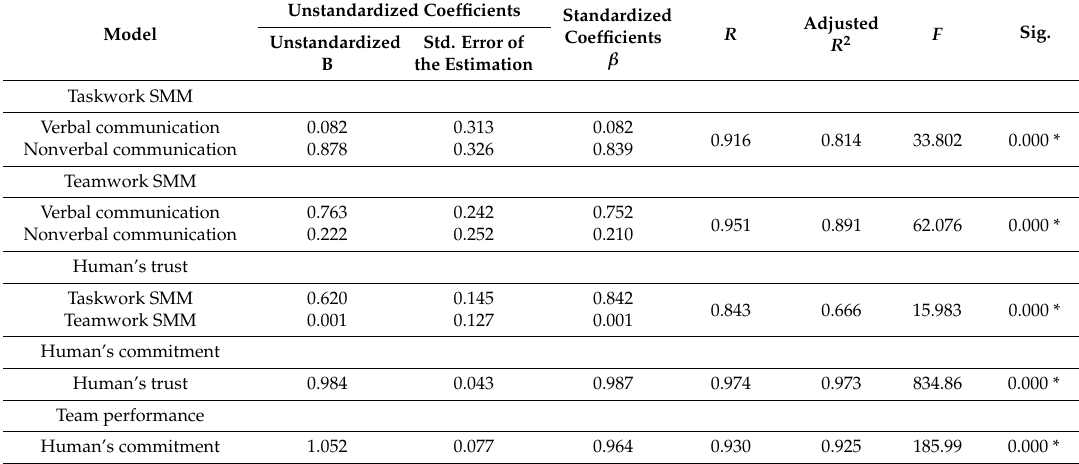
Table 4. Regression analysis to answer research